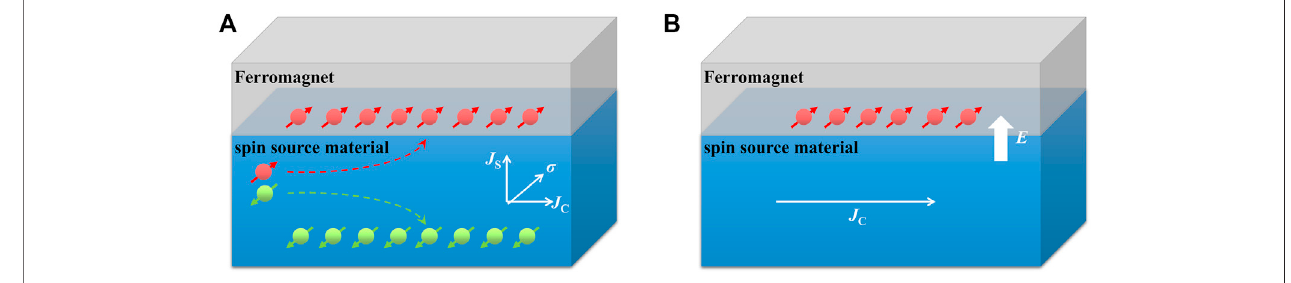
FIGURE 1 | (A) Illustration of the spin Hall effect in the spin source material. (B) Illustration of Rashba-Edelstein effect at the